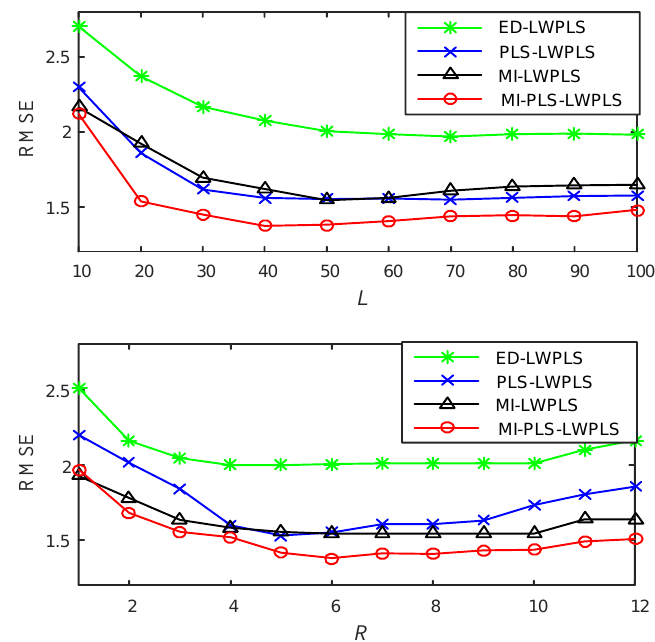
Figure 2. Influence of the changes of L and R on root mean square errors (RMSEs) of the four methods.